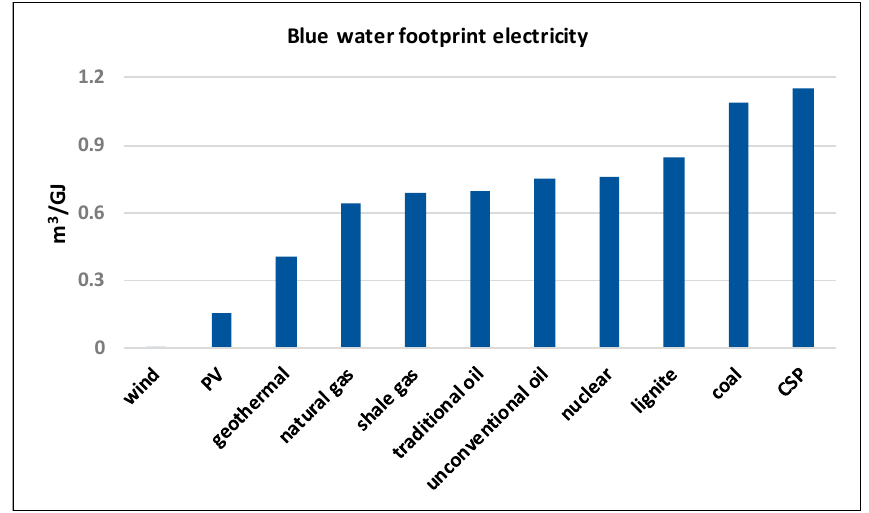
Figure 5. Blue water footprints of electricity form wind, photovoltaics (PVs), geothermal, natural gas, shale gas, traditional and unconventional oil, nuclear, lignite, coal and concentrated solar power (CSP; source: Mekonnen et al. [4]).